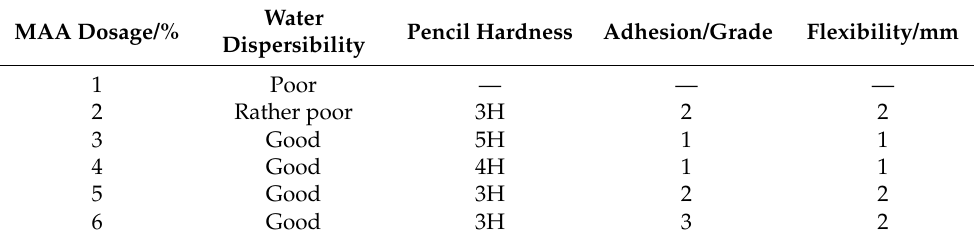
Table 6. Effect of the amount of MAA on the performance of the coating